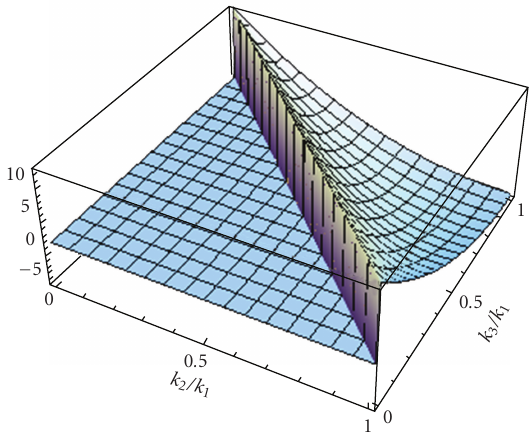
Figure 20: An ansatz − S orth in (199) for the orthogonal shape S 1 ansatz in (198). Note we added a minus sign in this